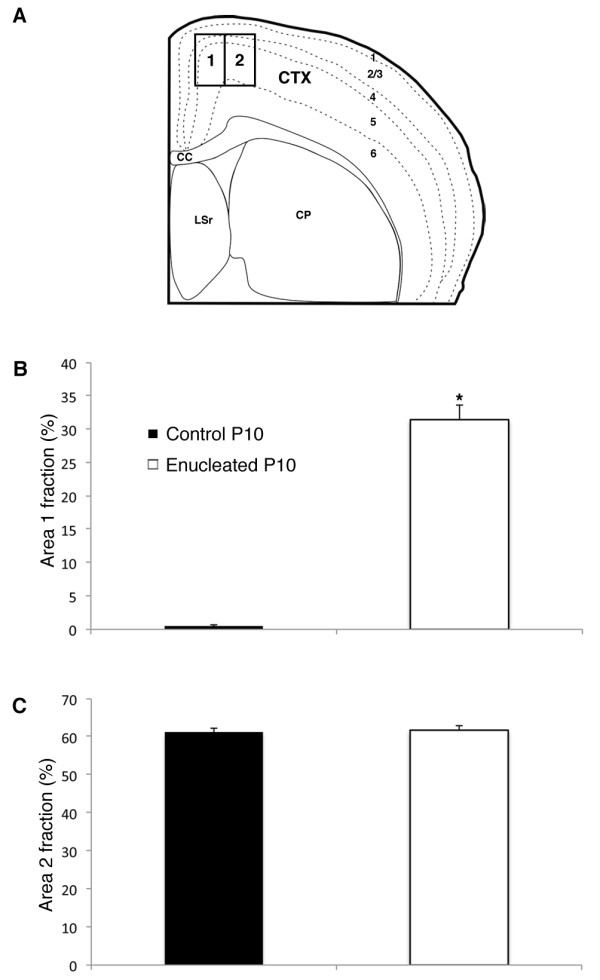
Analysis of ephrin A5 expression in two ROIs in the neocortex of control and enucleated mice. (A) Medial parietal cortex regions of interest overlaid on a representative coronal brain illustration. (B) Percent area fraction of cells expressing ephrin A5 within ROI1, located within the medial parietal cortex. A sharply increased percentage of transcript is observed in enucleated cases (31.46 ± 2.2%; df = 12; n = 7) when compared to control animals (0.49 ± 0.18%; df = 12; n = 7; P < 0.001; two-sample t-test). (C) Percent area fraction of cells expressing ephrin A5 within ROI2, located immediately lateral to ROI1. Percentage of ephrin A5 transcripts within the putative somatosensory cortex of enucleated animals (61.77 ± 1.18%; df = 12; n = 7) are not significantly different from controls (61.29 ± 1.00%; df = 12; n = 7; P = 0.47). CC: corpus callosum; CP: caudoputamen; CTX: cortex; df: degrees of freedom; LSr: lateral septal nucleus; ROI: region of interest.